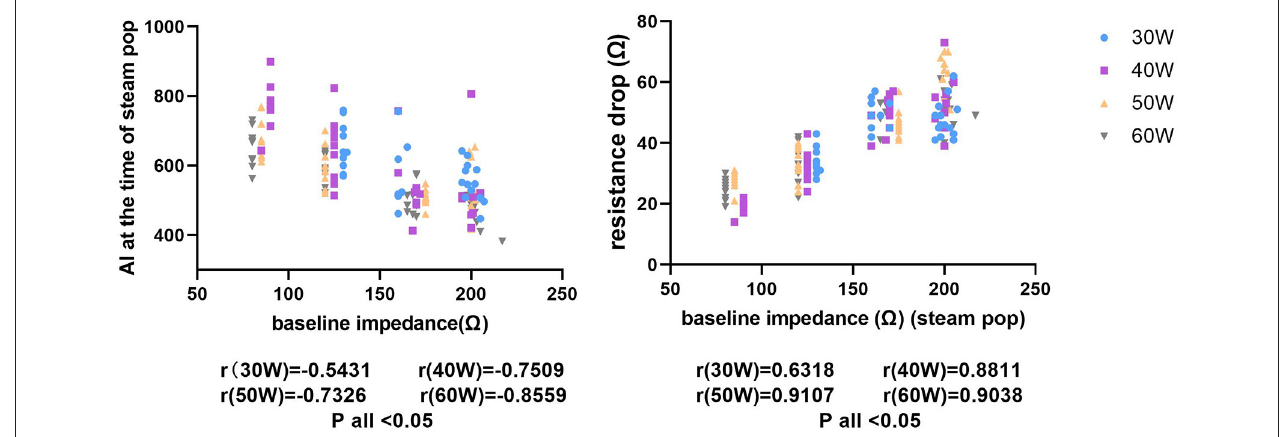
FIGURE 8 | The figure on the left shows the relationship between different baseline impedances and AIs during steam pops. The x -axis represents the baseline impedance and the y -axis represents the immediate AI when a steam pop occurs. The figure on the right shows the relationship between the baseline impedance and the impedance drop with a steam